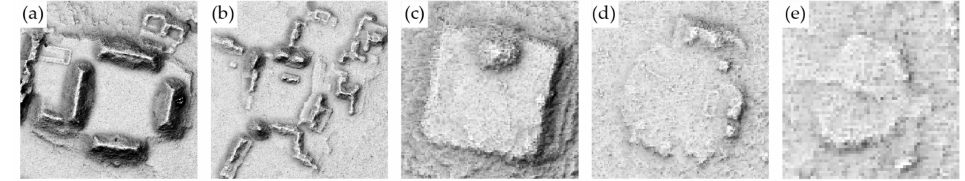
Figure 5. Di ff erent man-made platforms as evident in a 0.5 m resolution VAT. The scale